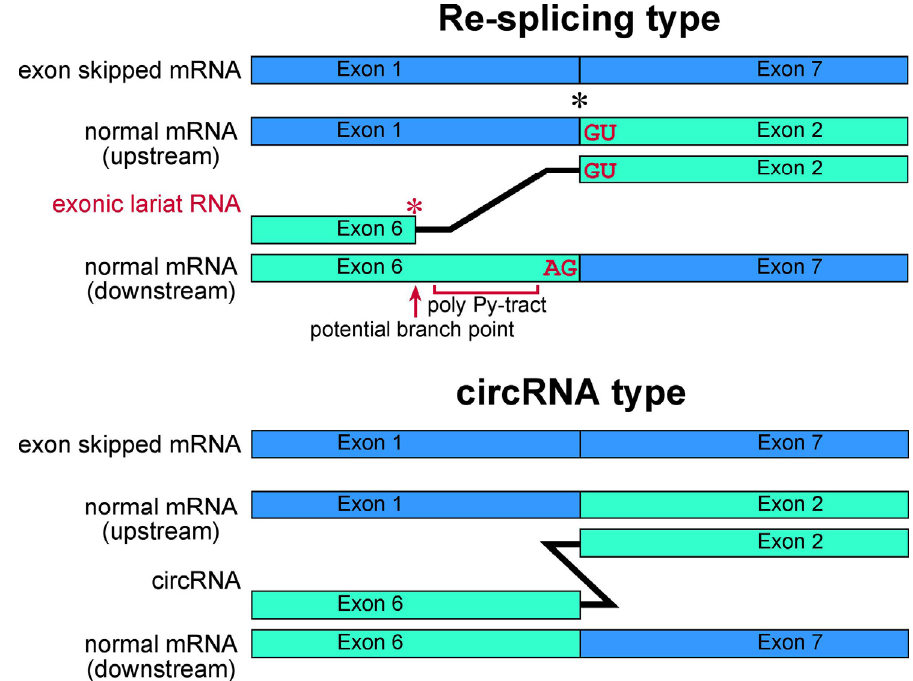
Figure 4. Schematic representation of exonic lariat RNA and circRNA. The mature mRNA re-splicing produces exonic lariat RNA. Therefore RT-PCR can amplify a product that lacks a potential poly pyrimidine-tract region between the potential branch point and 5' splice site of the re-splicing. The splice site consensus; GU and AG, should be required for the re-splicing. A red asterisk indicates frequent occurrence of the base substitutions [13]. Meanwhile, these features are not applicable in circRNA. Instead, the head-to-tail splicing should precisely connect exons of circRNA. As shown by black asterisk, an exon-exon junction of normal mRNA is used as the splice site in FHIT re-splicing event. However, it is possible that the splice sites of the re-splicing are located in the middle of exons in normal mRNA, such as TSG101